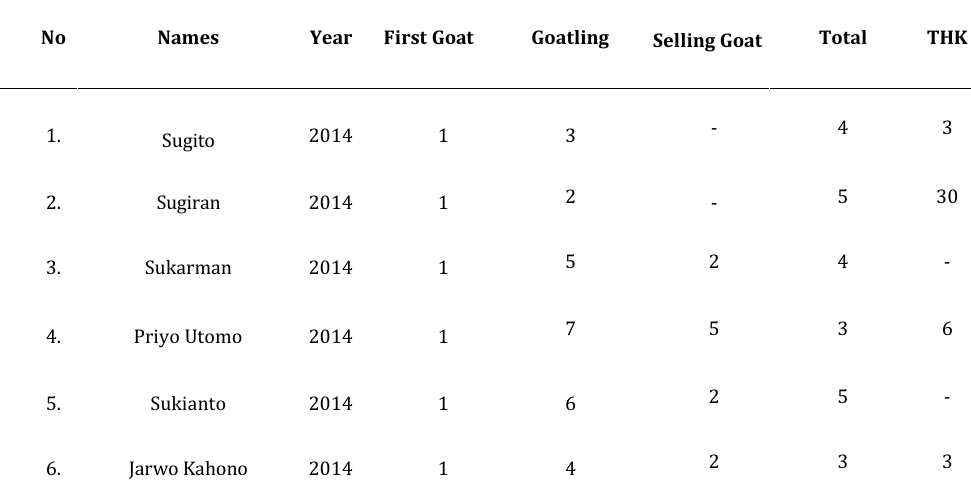
Table 2. Data from Ngudi Rejeki